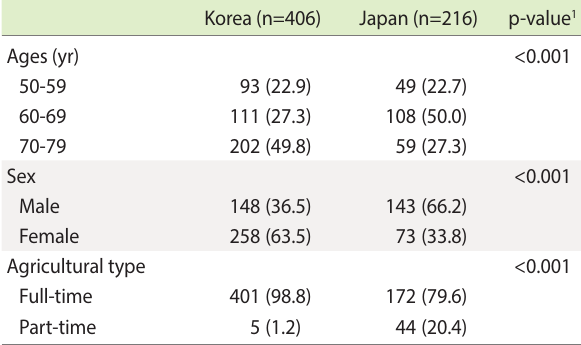
Table 1. General characteristics of subjects